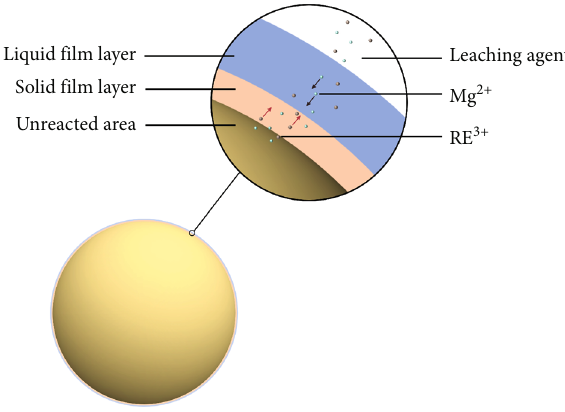
Figure 1: Schematic diagram of the rare earth ion exchange